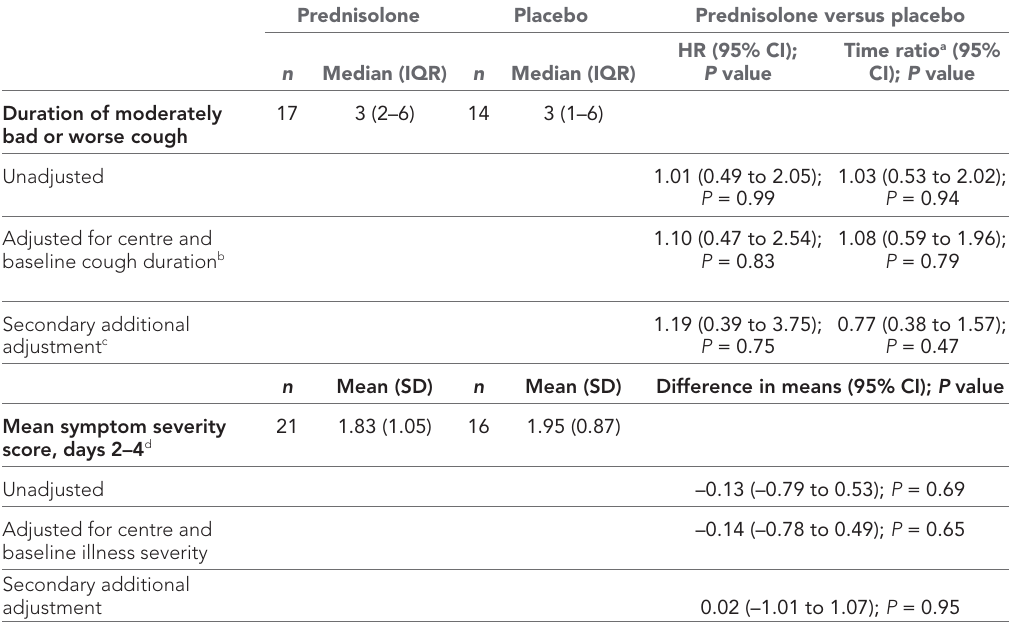
Table 2 Primary outcomes (main analysis groups)